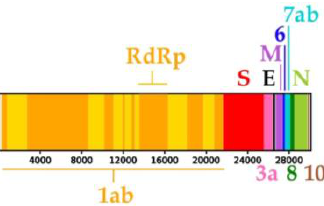
Figure 1. Positions of the coding sequences in the alignment of 75 Sarbecovirus genomes (30,115 nu- cleotides). For convenience, the size and scale are the same as the coloured genomic bootstrap (CGB) barcodes shown in sections 3.2 and 3.3. Abbreviations: E : envelope gene; M : membrane gene; N : nucleocapsid gene; RdRp : RNA-dependent RNA polymerase gene; S : spike gene; 1ab: ORF (Open Reading Frame) 1ab; 3a: ORF3a; 6: ORF6; 7ab: ORF7ab; 8: ORF8; 10: ORF10. The alternating yellow and orange colours in ORF1ab indicate different non-structural proteins, including RdRp